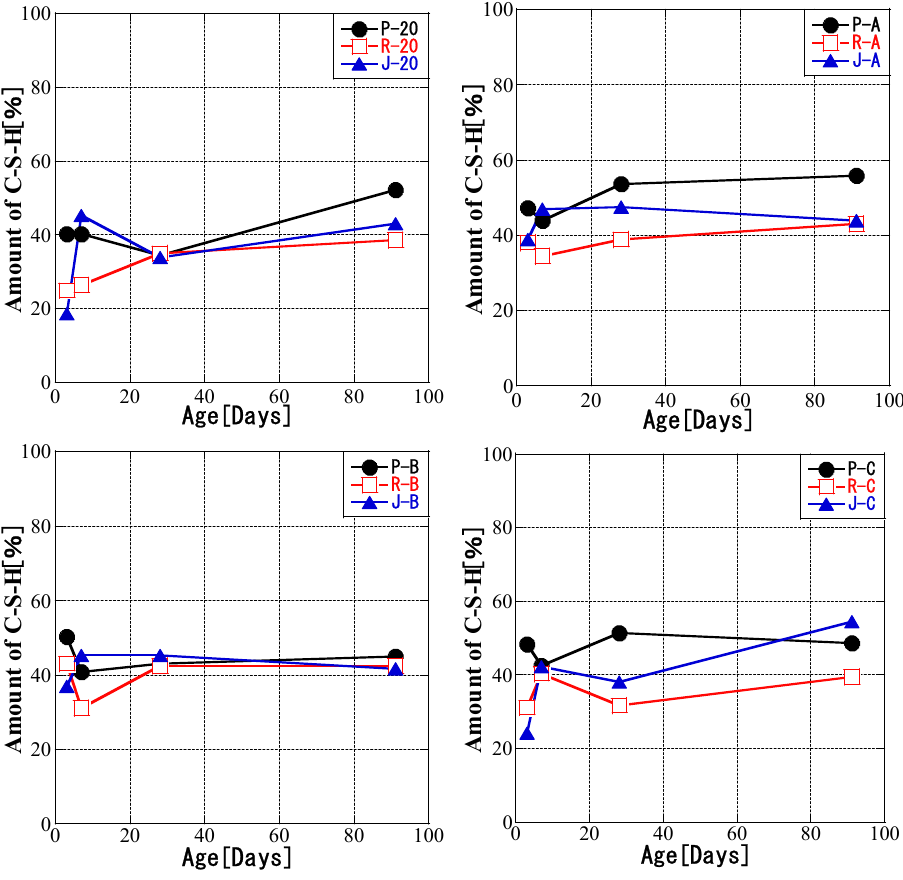
Figure 10. C-S-H production amount.